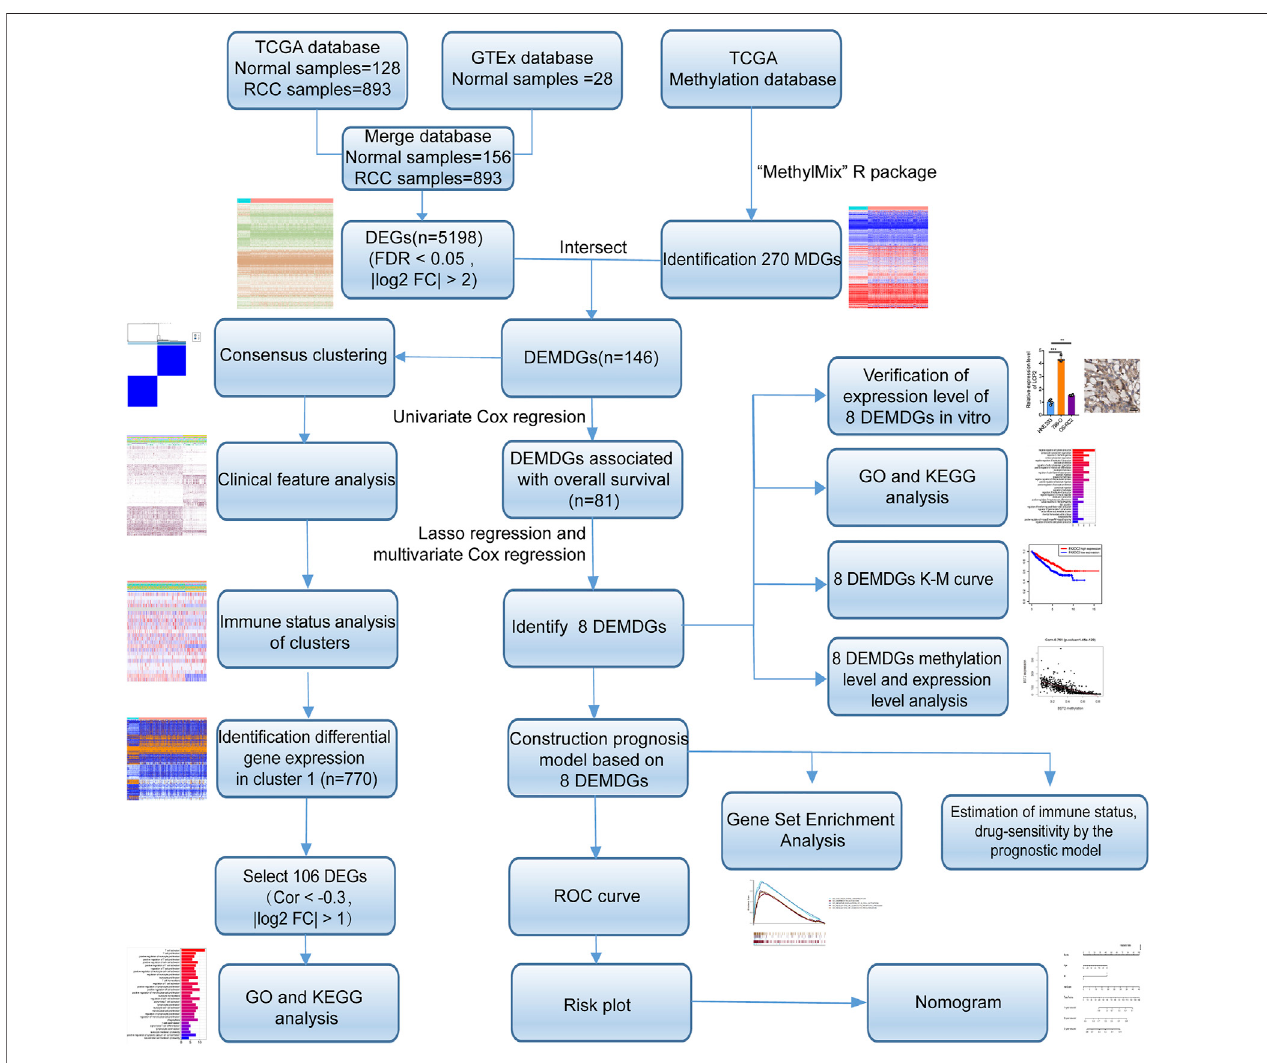
FIGURE1| Flowdiagram.TCGA,TheCancerGenomeAtlas;GTEx,genotype-tissueexpression;DEGs,differentiallyexpressedgenes;MDGs,methylation-driven genes; DEMDGs, differentially expressed methylation-driven genes; KEGG, Kyoto Encyclopedia of Genes and Genomes; GO, gene ontology; K – M, Kaplan – Meier.